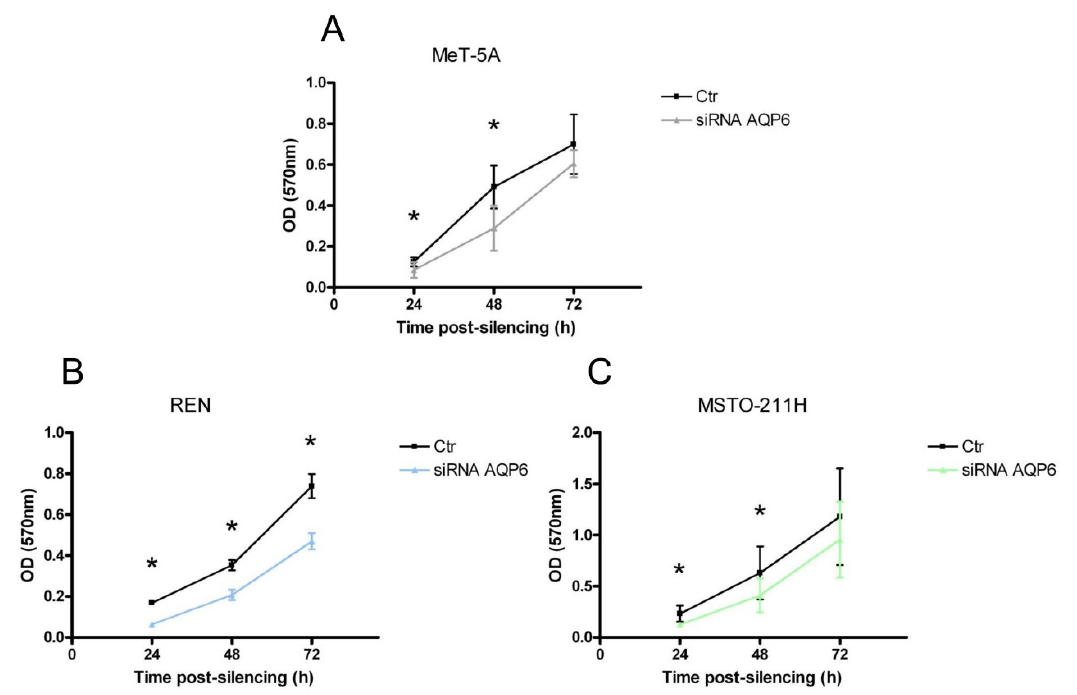
Figure 9. Effect of aquaporin-6 (AQP6) silencing on the cell proliferation of MeT-5A ( A ), REN ( B ), and MSTO-211H ( C ) cultured cells. Cell growth was evaluated by measuring the OD at 570 nm at 24, 48, and 72 h after cell silencing compared with scrambled silenced control cells. The initial cell number was about 25,000 cells/well. AQP6-null cells (siRNA AQP6) showed a significantly decreased proliferation compared with controls after 24 and 48 h from silencing in Met-5A and MSTO-211H cells and after 24, 48, and 72 h from silencing in REN cells. Values (OD at 570 nm normalized to the cell number) are mean ± SEM of cells for each of 4 different experiments. *, p < 0.05 (Student’s t -test).